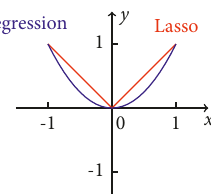
Figure 2: Descent speed of lasso and ridge